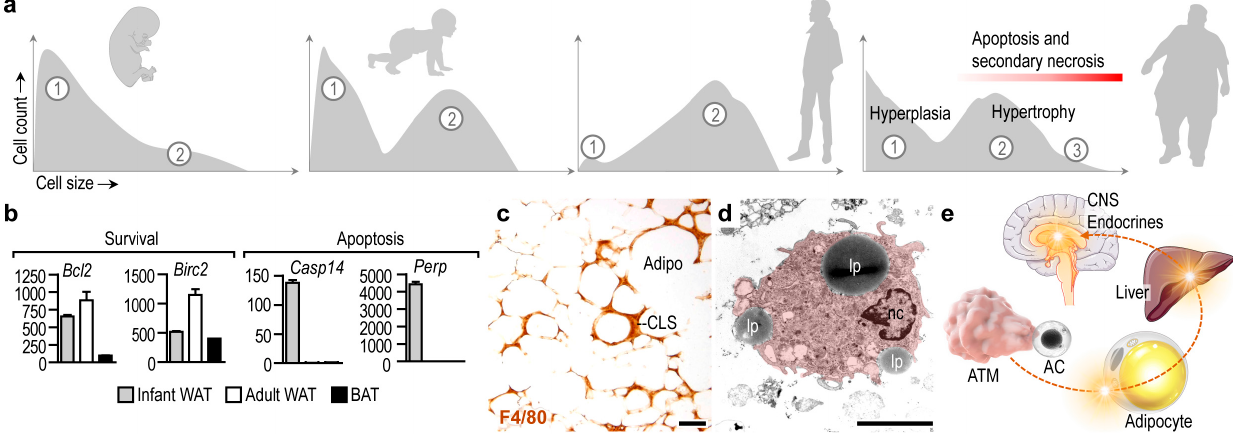
Figure 1. Adipocyte apoptosis and its metabolic impact. ( a ) In postnatal life, WAT undergoes differentiation and expansion. Differentiating adipocytes (cell population 1 (cid:13) ) are abundant after birth. In infancy, the prevalence of mature adipocytes (cell population 2 (cid:13) ) increases and, in adulthood, the lipid-storing mature adipocytes build-up the WAT. The number of differentiating and hypertrophic adipocytes (cell population 3 (cid:13) ) increases dramatically in obesity. Adipocyte hypertrophy is associated with apoptosis and secondary necrosis. Graphs modified from [20,22]. ( b ) Transcript level of survival factors Bcl2 (BCL2 apoptosis regulator) and Birc2 (baculoviral IAP repeat-containing 2) in infant and adult WAT and in adult BAT in the mouse. Note the high expression of the survival factors in adult WAT. In turn, the apoptosis markers Casp14 (caspase 14) and Perp (TP53 apoptosis effector) are highly expressed in infant WAT, likely due to differentiation or